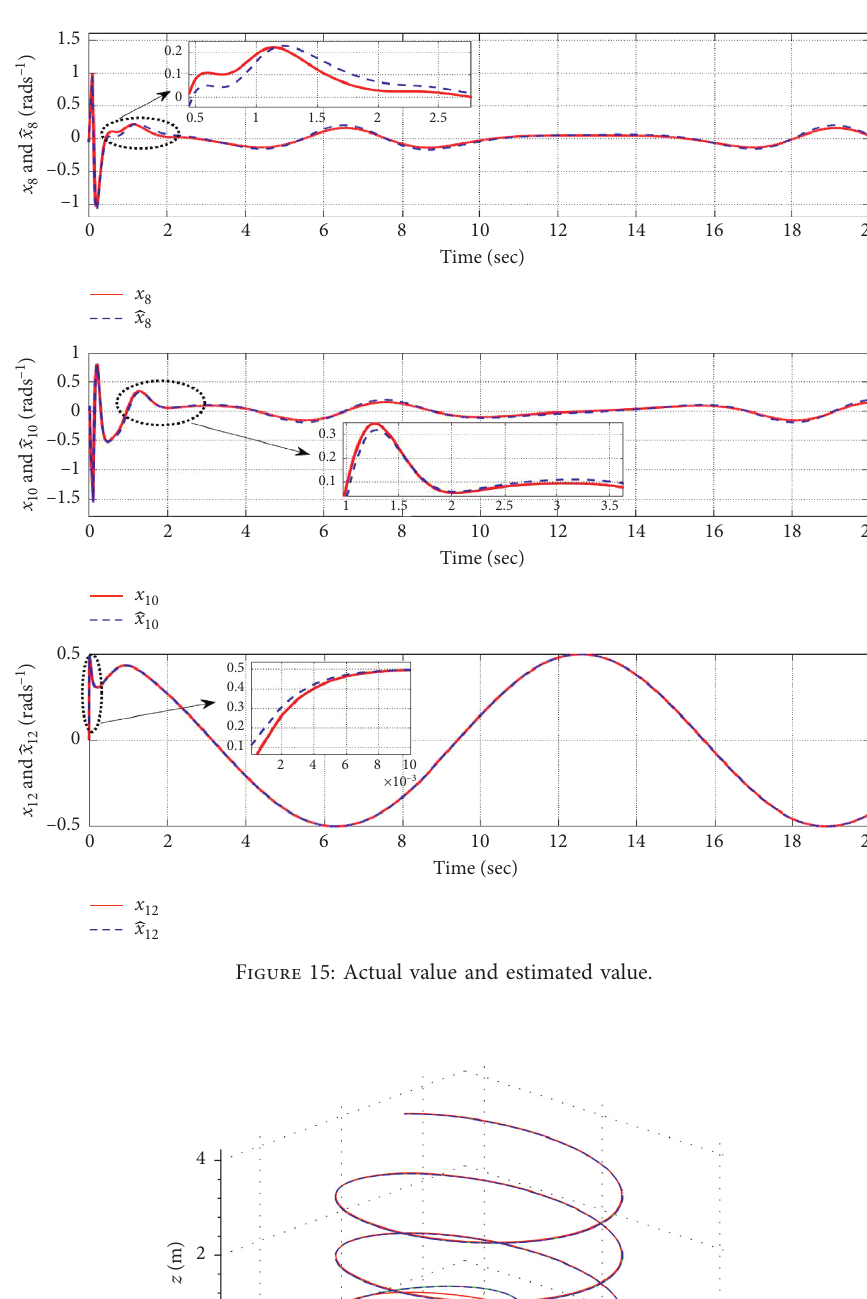
Figure 16: Space diagram of the position with normal, 15%, 30%, and 50% parameter